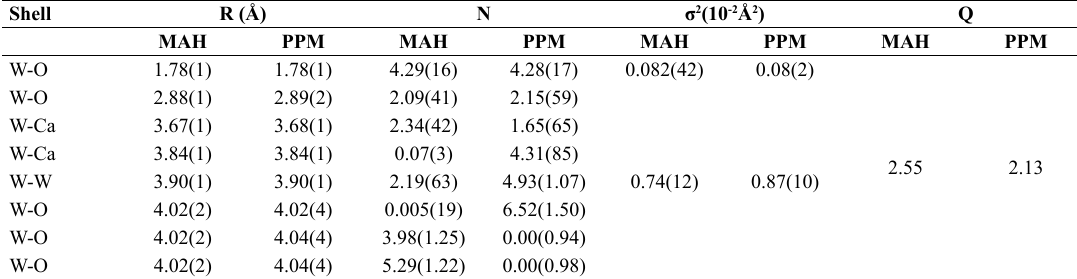
Table 3. W LIII-edge EXAFS simulation results. R is the distance from the central atom, N is the average coordination number, σ 2 the Debye–Waller factor, and Q the quality factor.